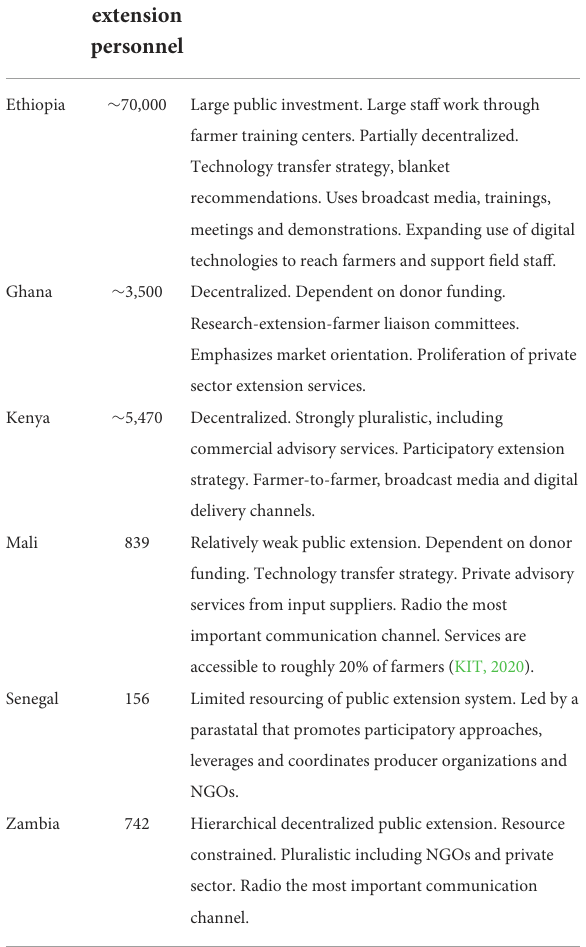
TABLE 4 Key features of agricultural extension services in focus